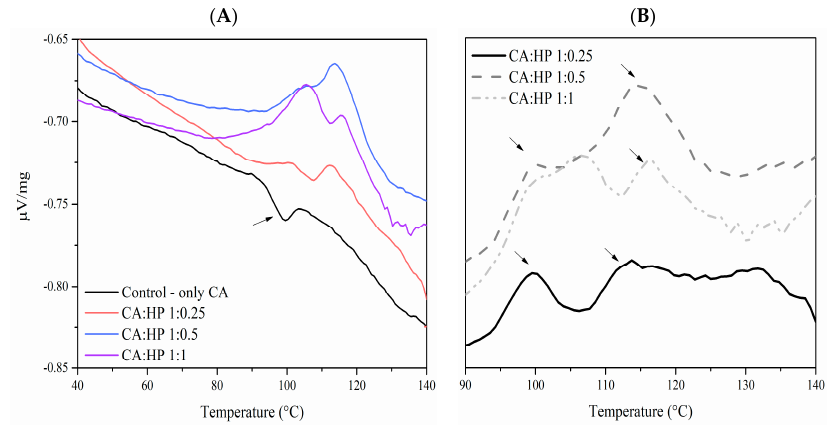
Figure 1. ( A ) Differential scanning calorimetry (DSC) thermograms of starches showing exergonic citric acid (CA) cross-linking reactions in a sodium hypophosphite (HP)-dependent manner. The arrow indicates an endergonic reaction; ( B ) Control data subtracted indicating HP-dependent cross-linking exotherms (arrows).